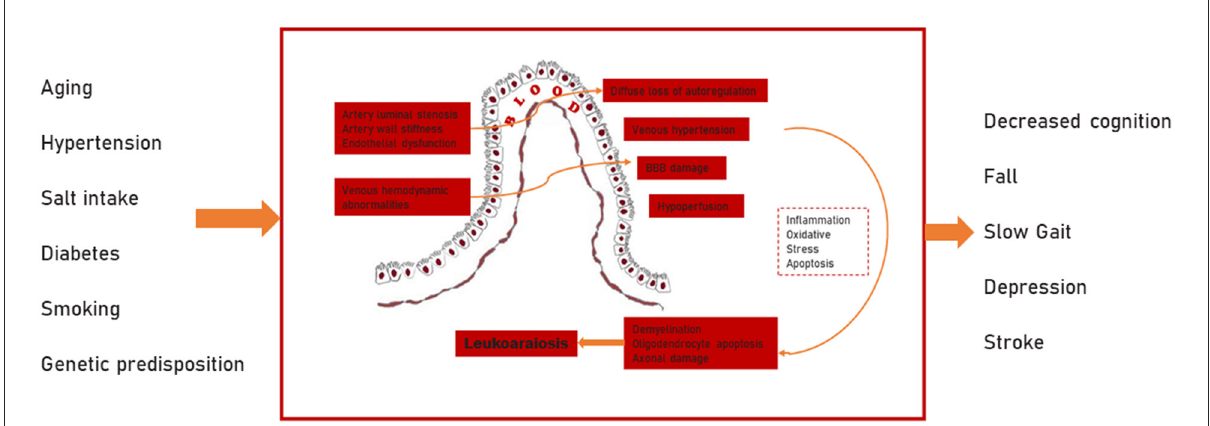
FIGURE1 Pathophysiology of leukoaraiosis. The existence of artery luminal stenosis, artery wall stiffness, endothelial dysfunction, and venous drainage limitation due to risk factors such as aging, hypertension, diabetes, and genetic factors, etc. These directly contributes to the diffuse loss of autoregulation, venous hypertension, BBB damage, and hypoperfusion. Thereafter, demyelination, oligodendrocyte apoptosis, and axonal damage occurs in response to stimulation by inflammation, oxidative stress, and apoptosis. The above processes are considered to be the main pathogenic factors of LA (BBB, blood brain